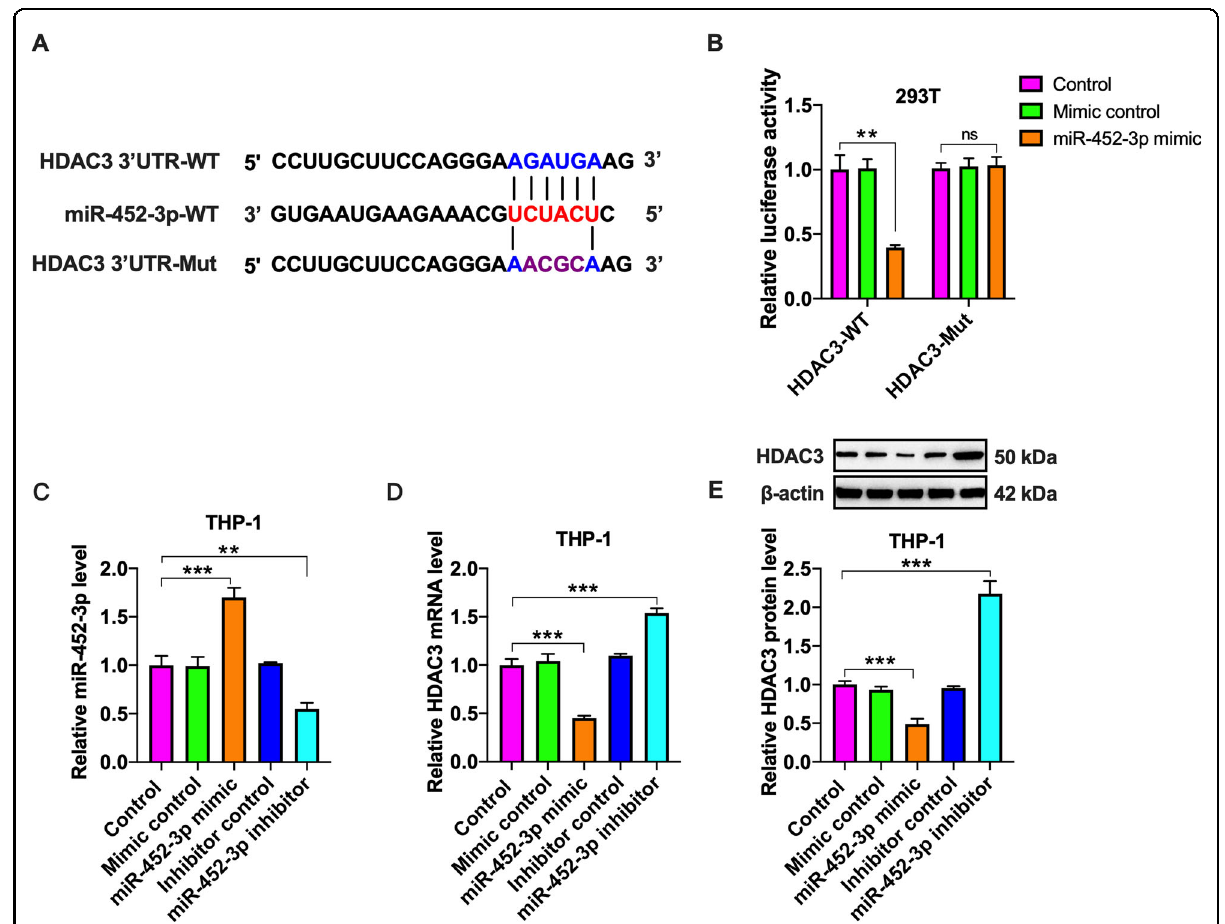
Fig. 6 Identi fi cation of HDAC3 as a direct target of miR-452-3p. A Schematic of miR-452-3p binding site in the 3 ′ UTR of HDAC3 mRNA and corresponding mutation. B The luciferase reporter plasmids (HDAC3-WT and HDAC3-Mut) were co-transfected into 293T cells with miR-452-3p mimic or its negative control. Luciferase activity was measured after 48 h. C – E THP-1 macrophages were transfected with mimic/inhibitor or their negative controls for 48 h; C qRT-PCR analysis of miR-452-3p expression. D , E The mRNA and protein levels of HDAC3 were determined by qRT-PCR and western blot, respectively. Data are represented as mean ± SD from three independent experiments. ** P < 0.01, *** P < 0.001; ns not signi fi